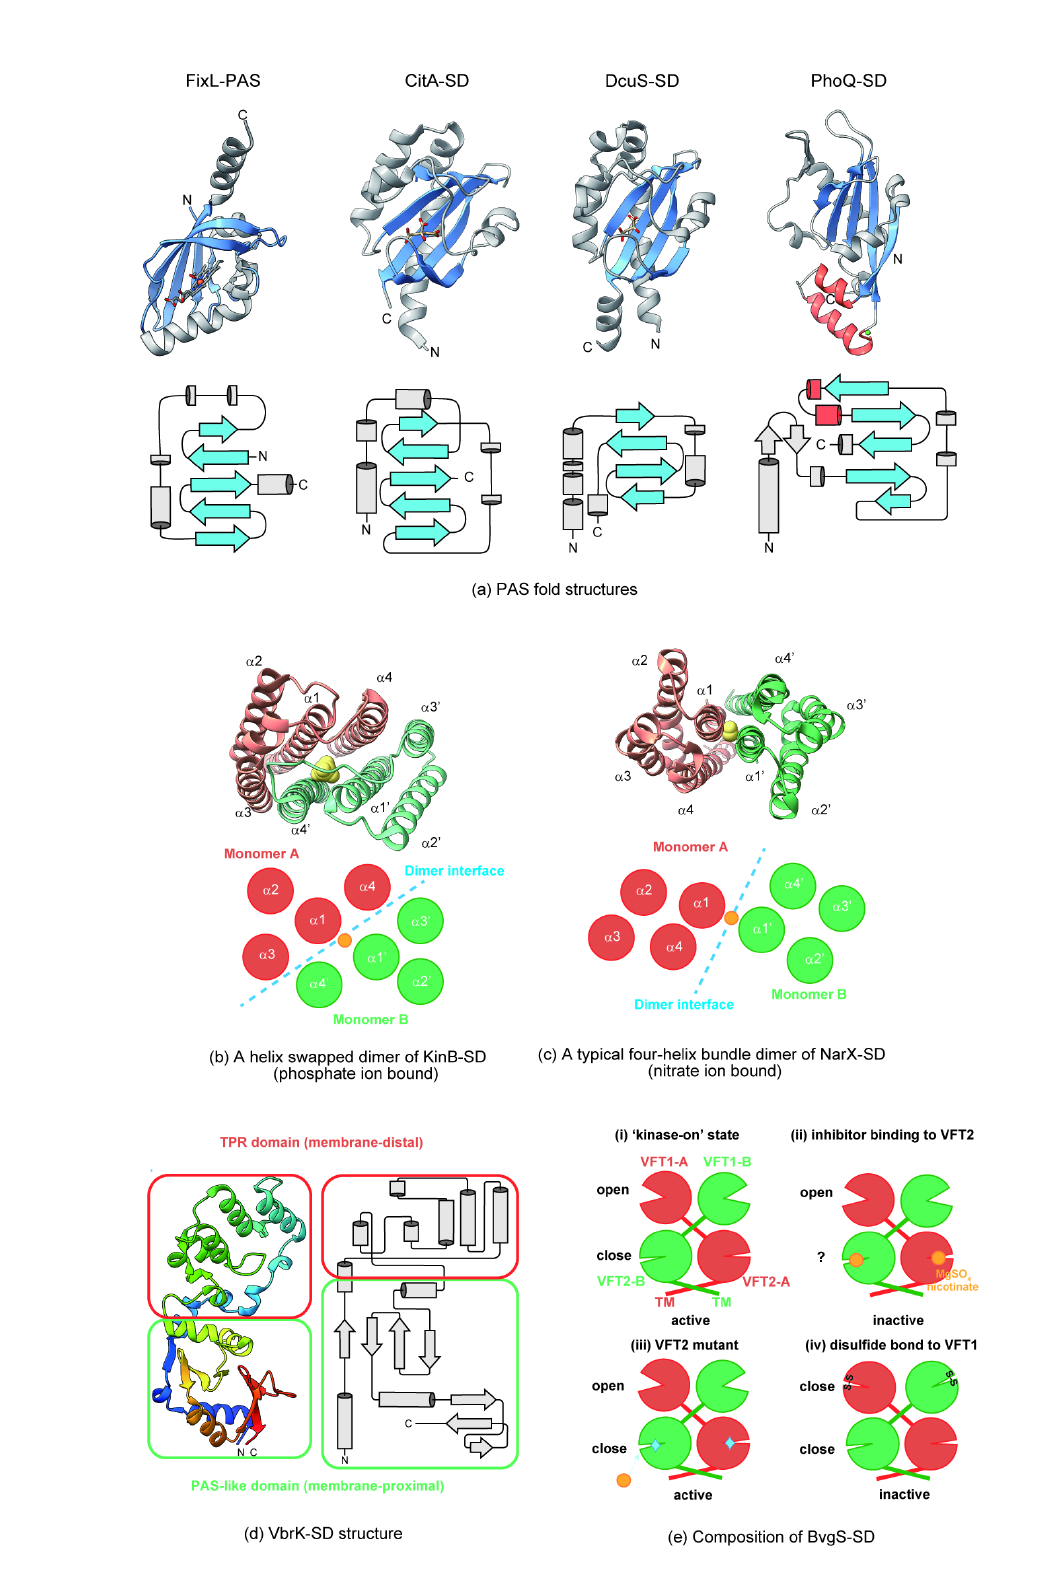
Figure 2. Structure comparison of extracellular sensor domains. ( a ) Comparison of PAS fold structures. FixL (1DP6) has a PAS fold as an intracellular signal-sensing domain. CitA (2J80), DcuS (3BY8), and PhoQ (3BQ8) have a PAS fold as an